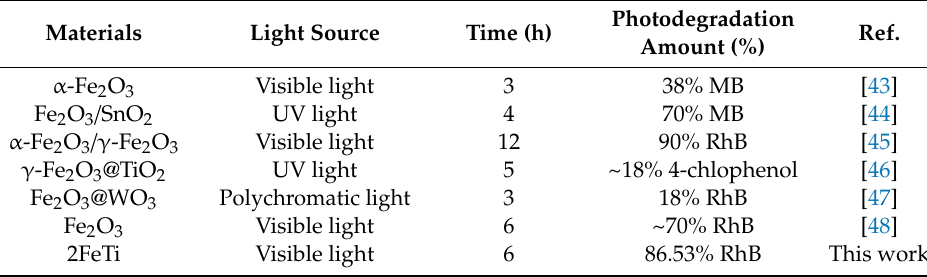
Table 4. Comparison of the photocatalytic performances of Fe 2 O 3 -based materials.